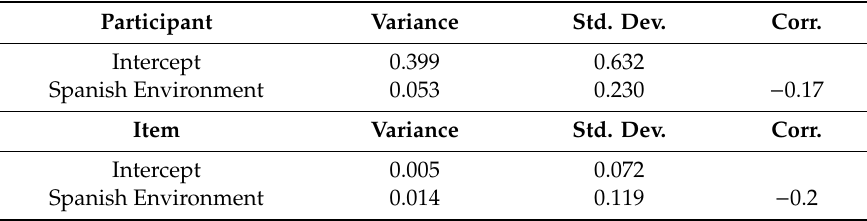
Table A3. Global Accent Rating Model Random E ff ects.